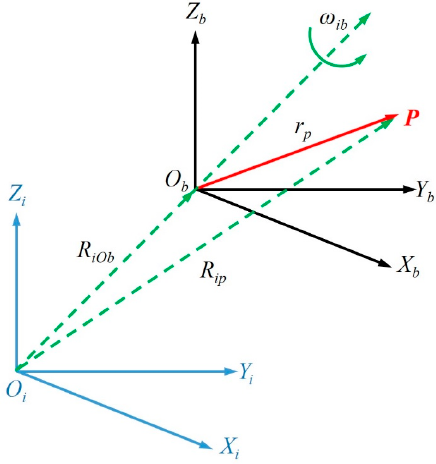
Figure 11. Schematic diagram of the lever arm effect.